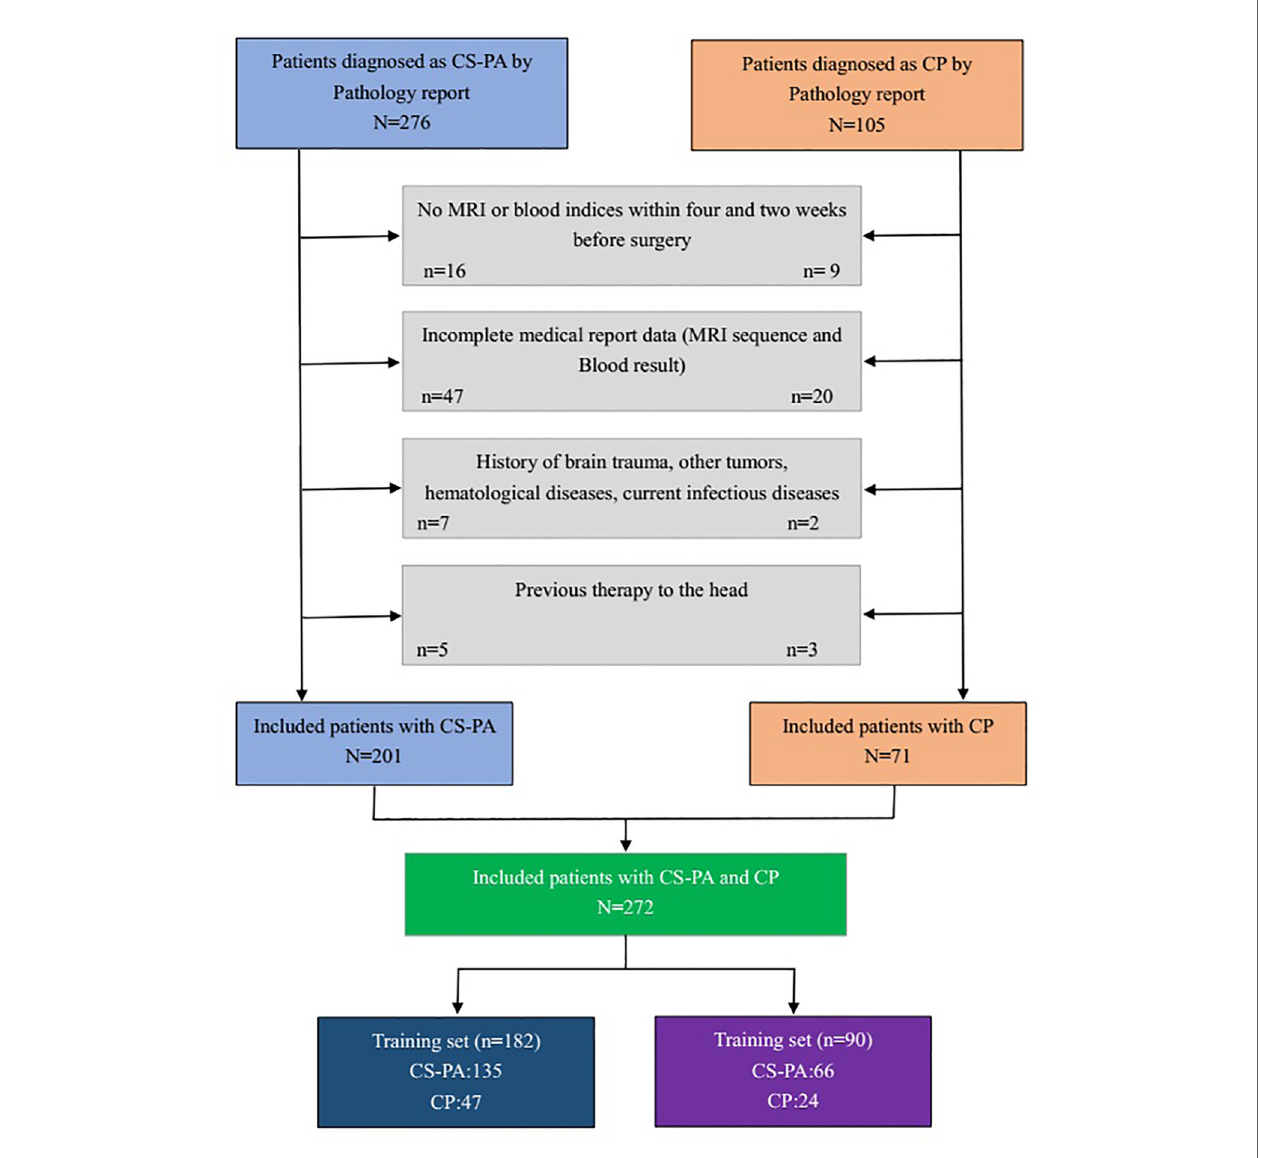
FIGURE 1 | The fl owchart of patient